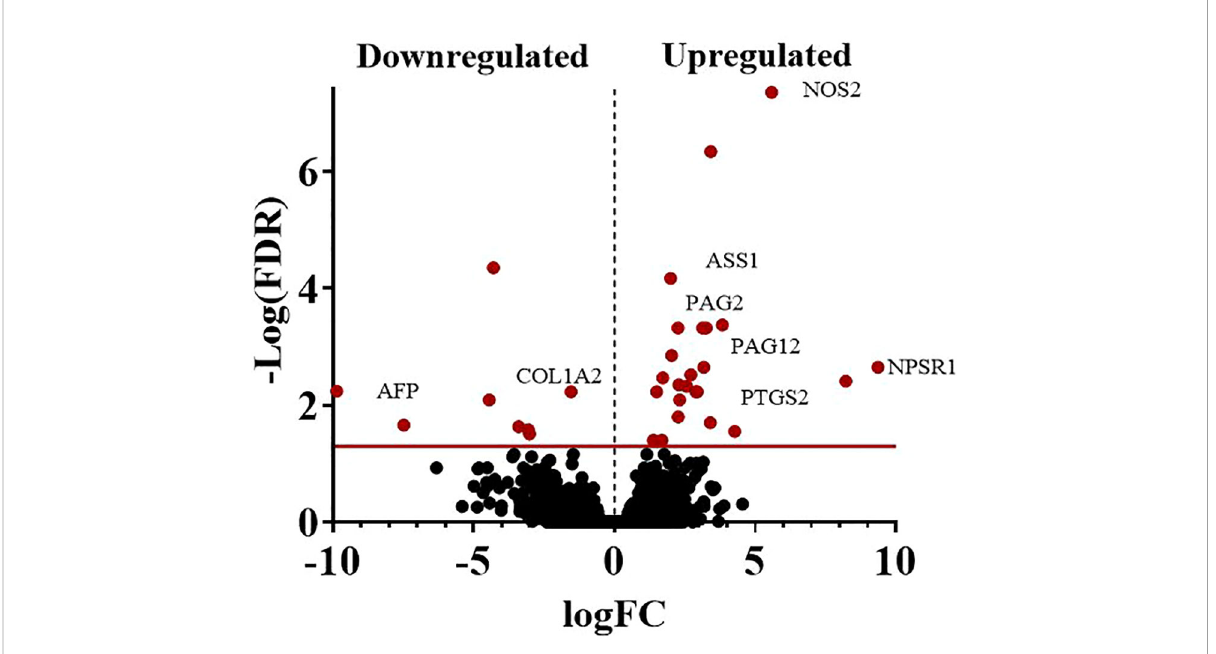
FIGURE 5 Volcano plot representing the number of DEGs when comparing conceptuses derived from +FLI or -FLI treated embryos. At a sequencing depth of 50 million reads per sample, 32 genes were differentially expressed. Nine genes were down-regulated, and 23 genes were up- regulated in the +FLI group. FDR < 0.05.